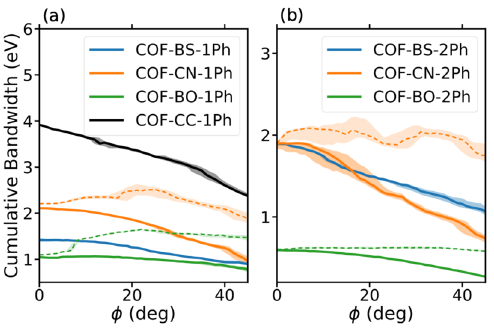
Figure 10. Cumulative bandwidth for different rotation angles φ for 1Ph COFs ( a ) and 2Ph COFs ( b ). Solid lines focus on the upper π -groups (near the Fermi-level) and dashed lines show the measurement for all π -groups. Colored areas indicate the numerical error of CBW due to a change of threshold parameters by